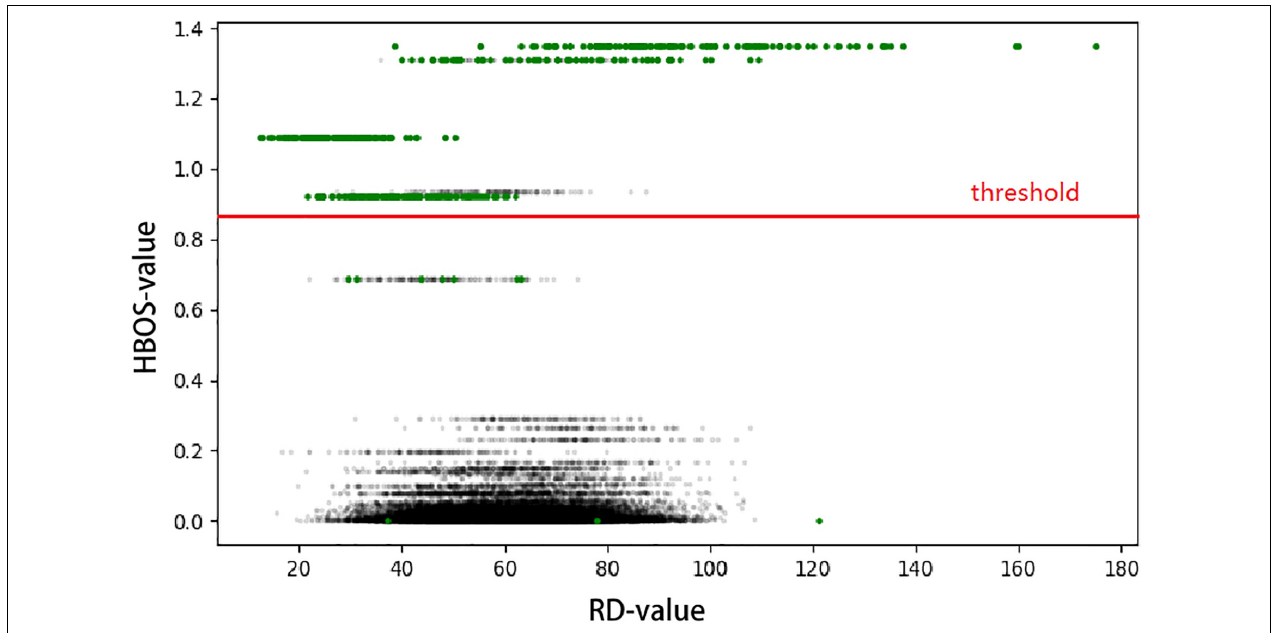
FIGURE 2 | The RD value was used as the x -axis and the HBOS of each bin as the y -axis to construct a scatter plot. The generated profile can greatly separate the normal area and the variation area. The green point is the ground truth of CNV, and the parts above the red line are predicted as CNV regions.